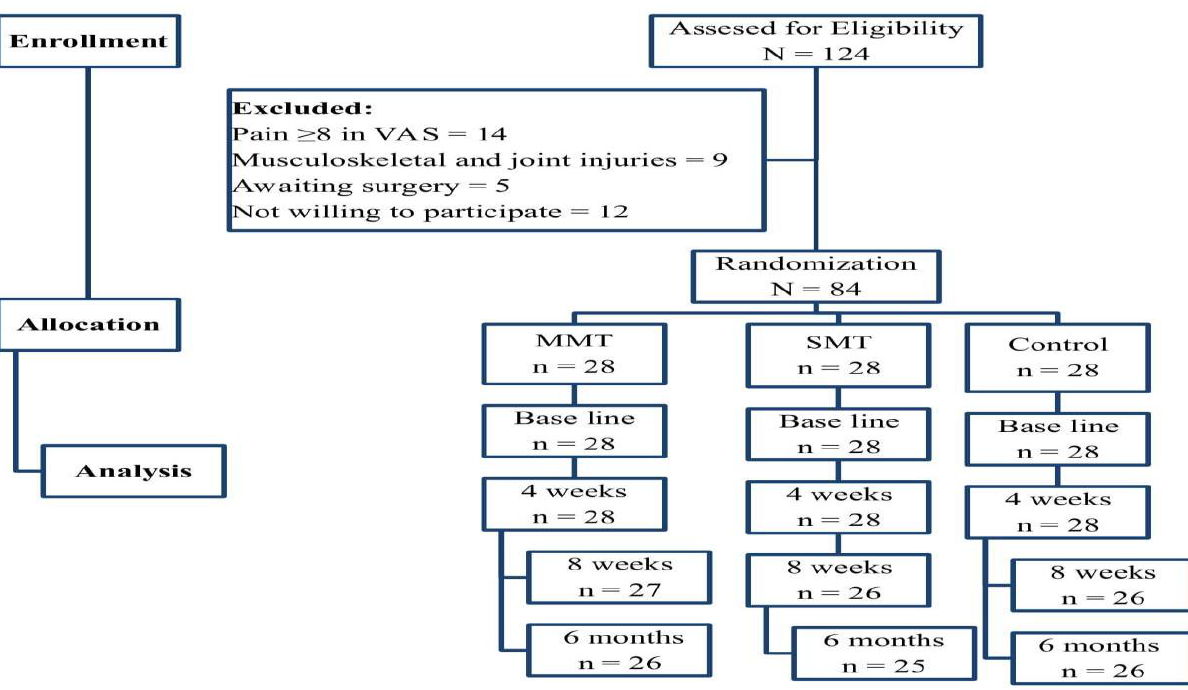
Figure 1. Flow chart showing the study detail. Table 1. Demographic details of the MMT, SMT, and control